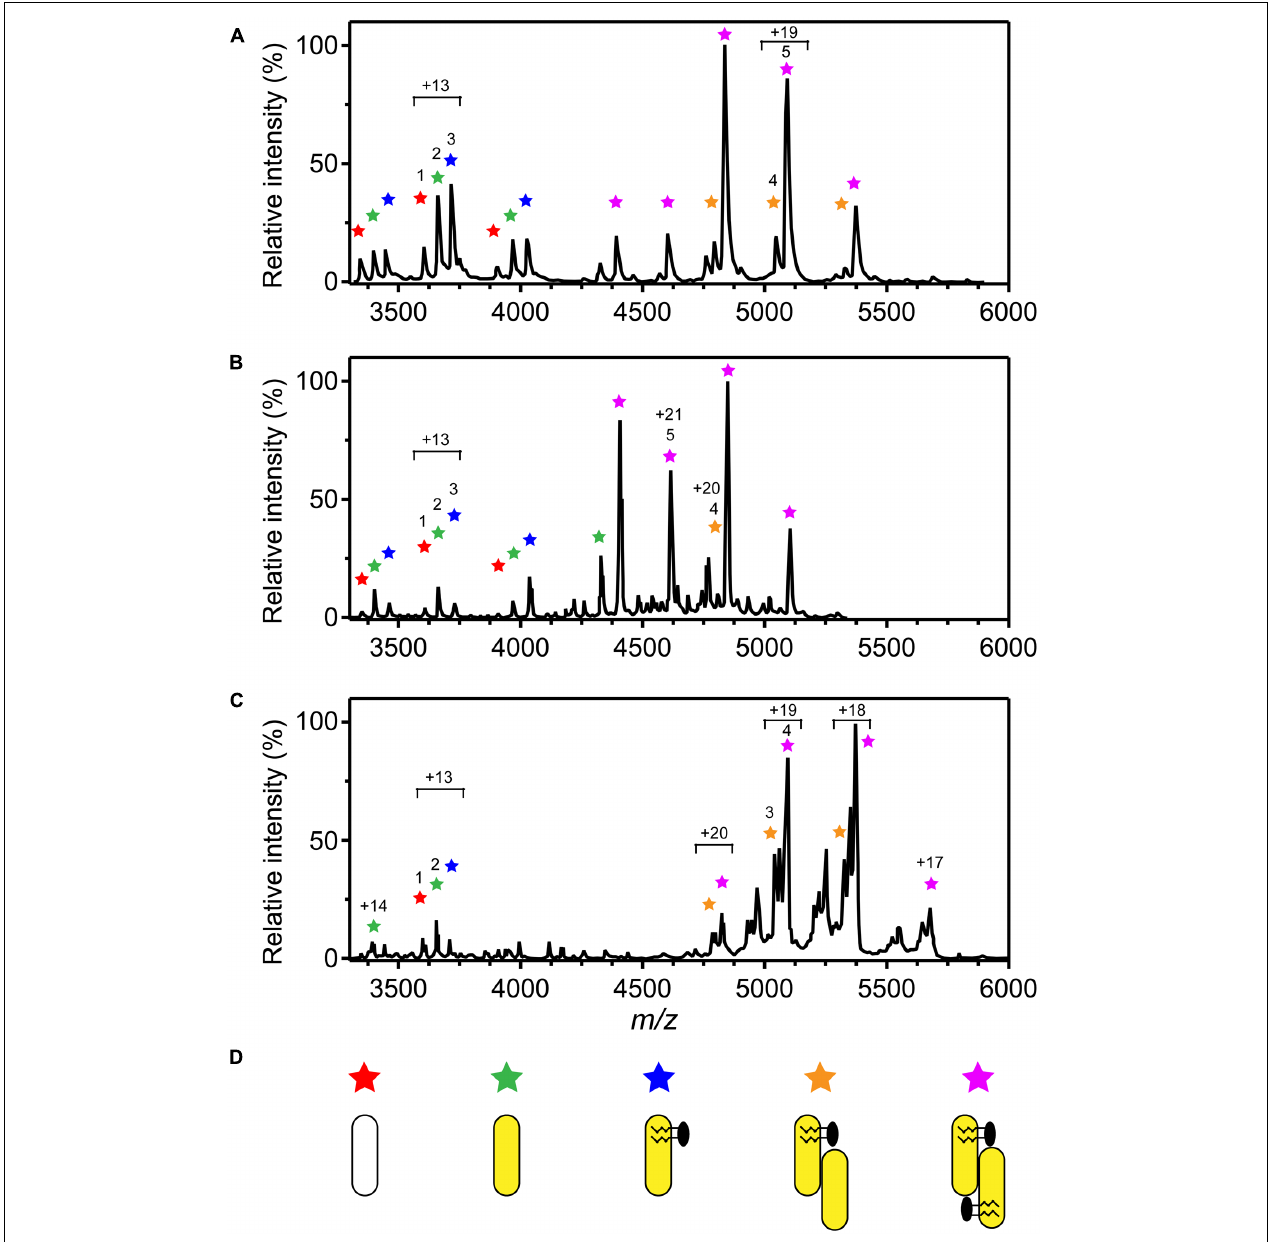
FIGURE 4 | Oligomer distribution and lipid composition of 3HB6H enzymes as determined by native ESI-MS. Mass spectra were recorded in 50 mM ammonium acetate, pH 6.8. (A) Mass spectrum of 3HB6H. (B) Mass spectrum of Rj 3HB6H. (C) Mass spectrum of Pa 3HB6H. Masses and intensities of numbered peaks are listed in Table 5 . (D) Cartoons of the various subunit compositions. Apoprotein is indicated in white, holoprotein in yellow and lipid molecules in black.